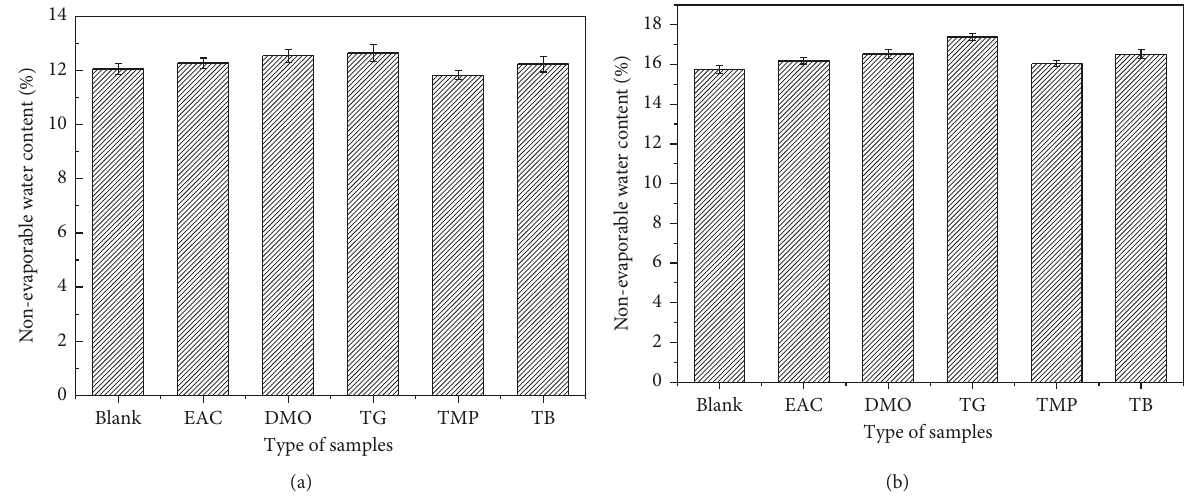
Figure 3: Effect of ester on nonevaporation water content of cement paste: (a) 3d and (b)